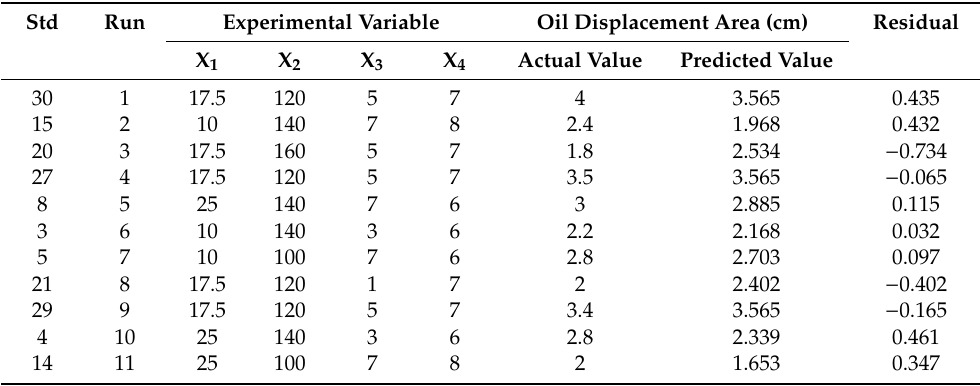
Table 2. Combination treatment matrix for biosurfactant production optimization and value for variables of the RSM experimental